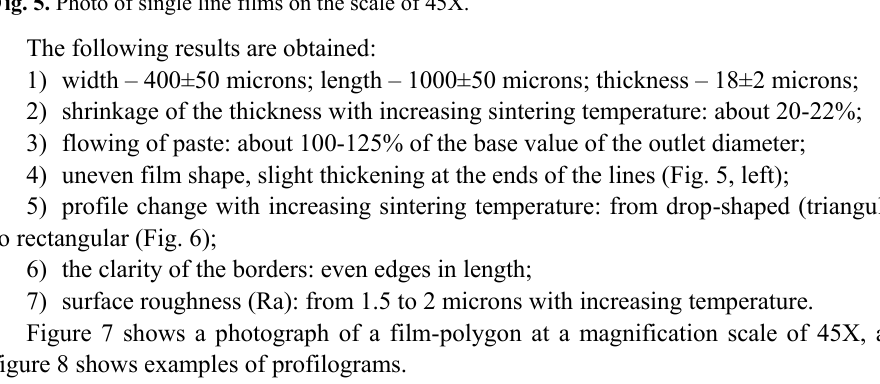
Fig. 5. Photo of single line films on the scale of